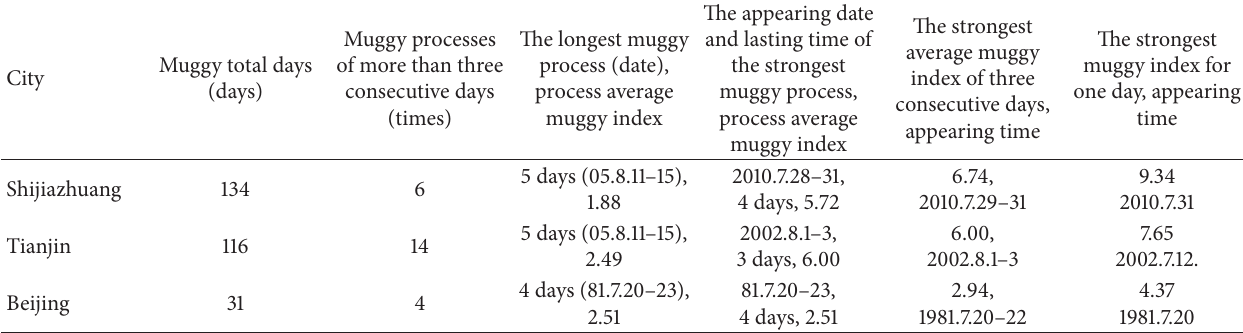
The strongest muggy index for one day,